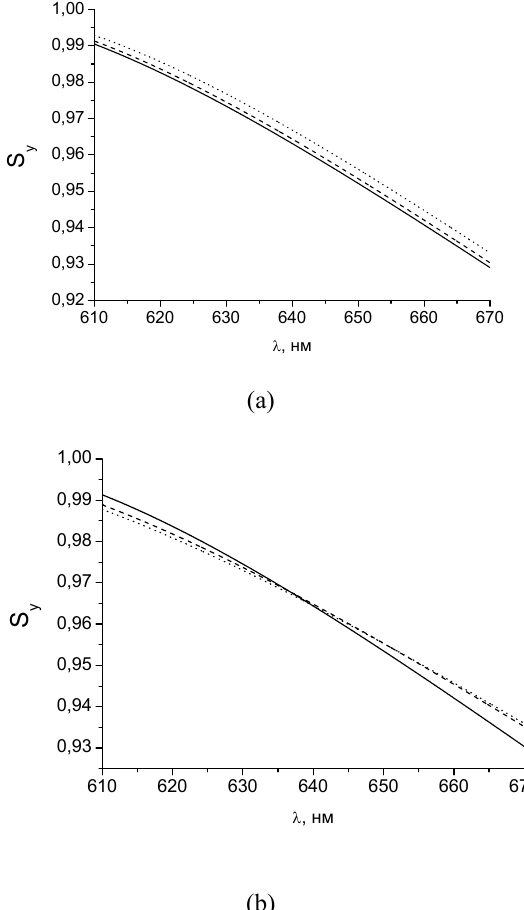
Figure 11: Spectral dependence of the expected value of transverse spin (in ħ units per photon) for plasmon- polariton formed at the boundary of the metal-dielectric multilayered Ti O /Ag structure and a dielectric: а ) water 3 5 =ε ); b) water (solid line), glyserine ( 769.1 1 =ε ) (dashed lline), optical glass BAF 10 ( 170.2 1 =ε ) (dotted line). Optical axis is oriented under ( 753.2 1 the angle: а ) θ =1 о (solid line), 3 о (dashed line), 5 о (dotted line); b) 3 о